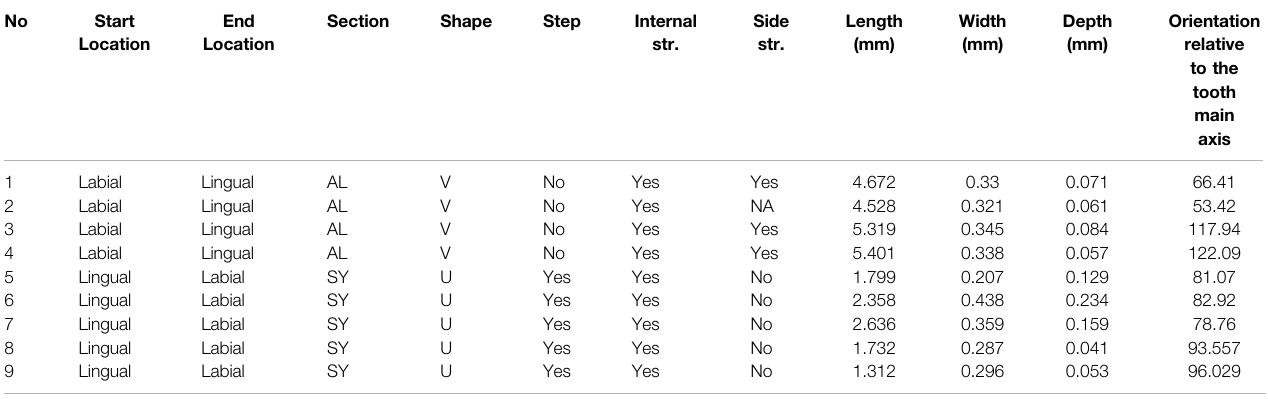
TABLE 3 | Morphometric and technological data on the incisions engraved on occlusal aspect of the QG10 perforated red deer tooth. No Start Location